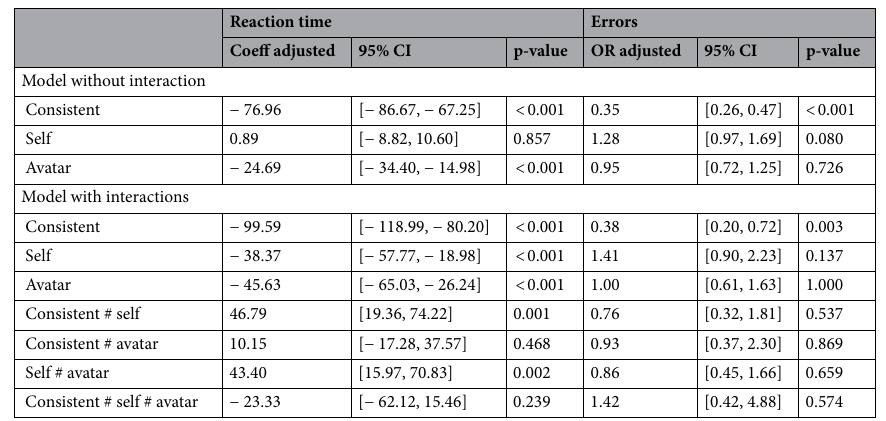
Table 2. Results of multiple mixed regression models with and without interaction terms (#): linear for mean reaction times (N = 10,464 observations) and logistic for errors (N = 10,432 observations). N = 82 participants.